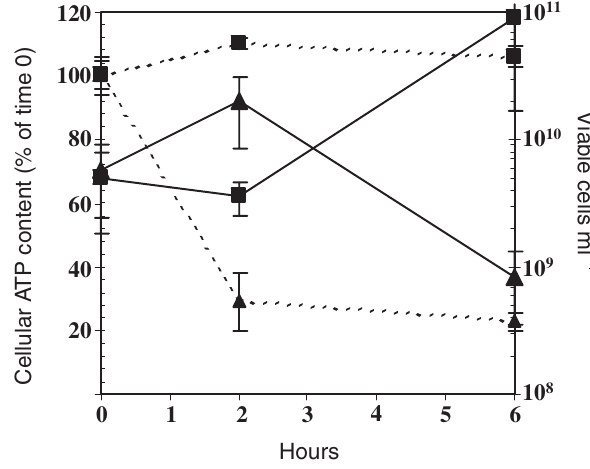
Figure 5. Cellular ATP content following molybdate addition. Num- ber of viable cells ( (cid:4) , (cid:7) ) and ATP levels ( (cid:4) -- , (cid:7) --) of F. acid-